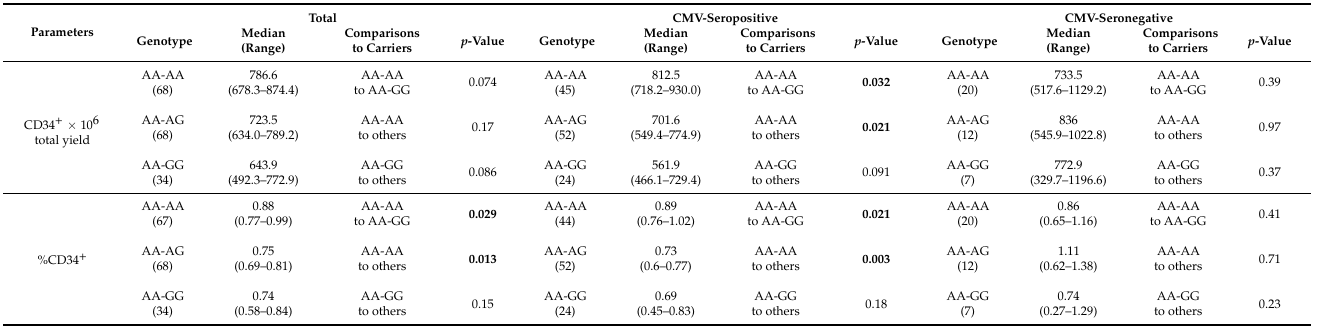
Table 7. Association analysis between combination of rs28649799 and rs4693608 SNPs and the number of CD34 + cells following administration of G-CSF to healthy donors after the first apheresis.